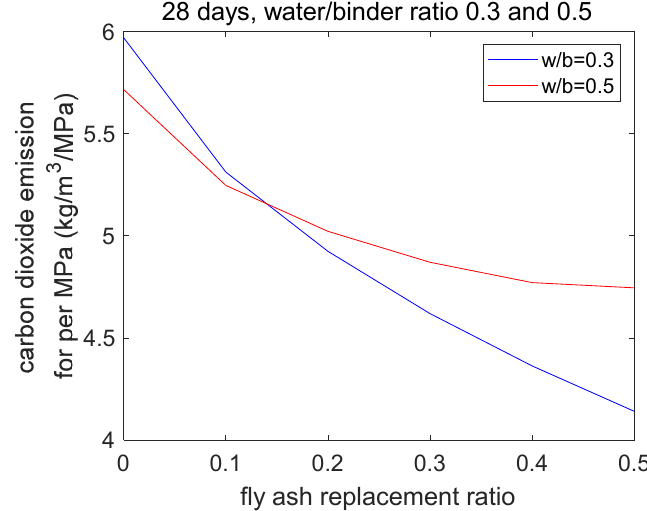
Figure 7. Effect of W/B ratio of concrete on CO 2 emissions for 1 MPa strength.